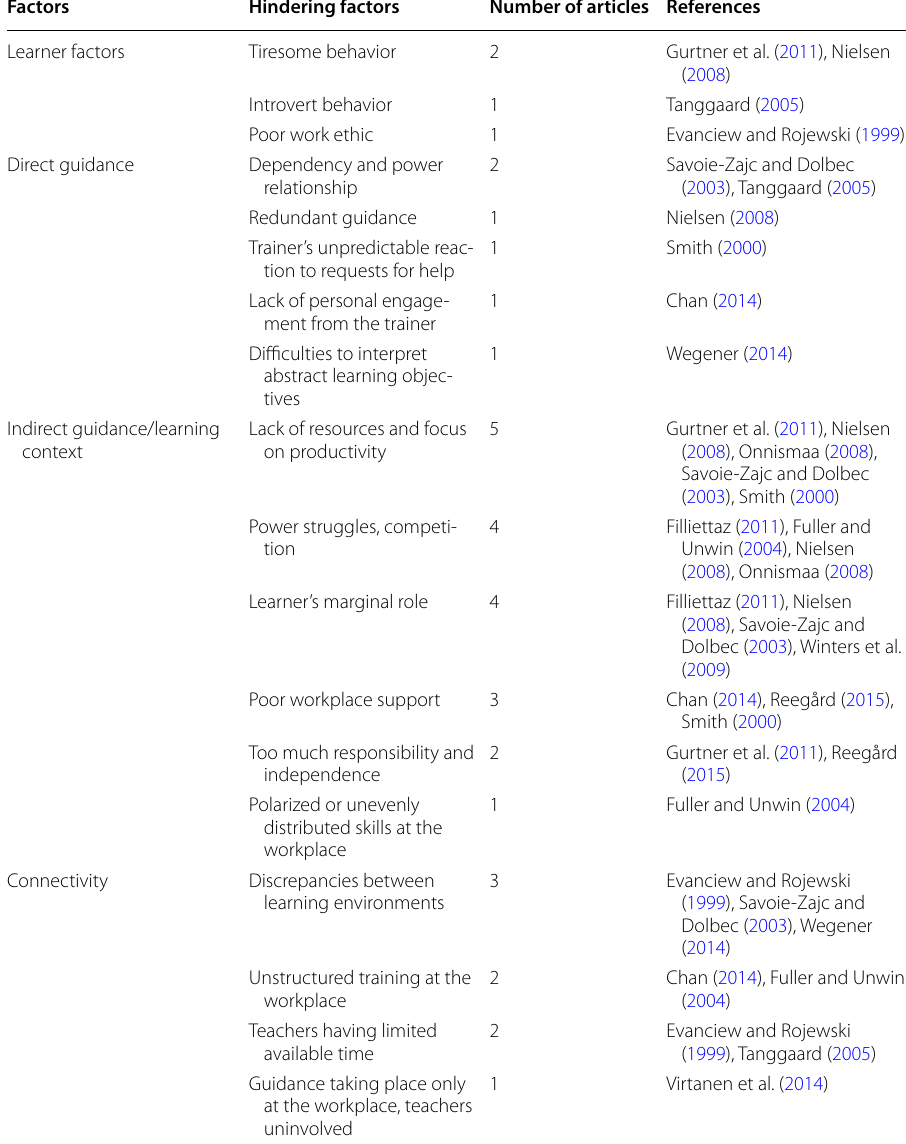
Table 5 Factors hindering guidance